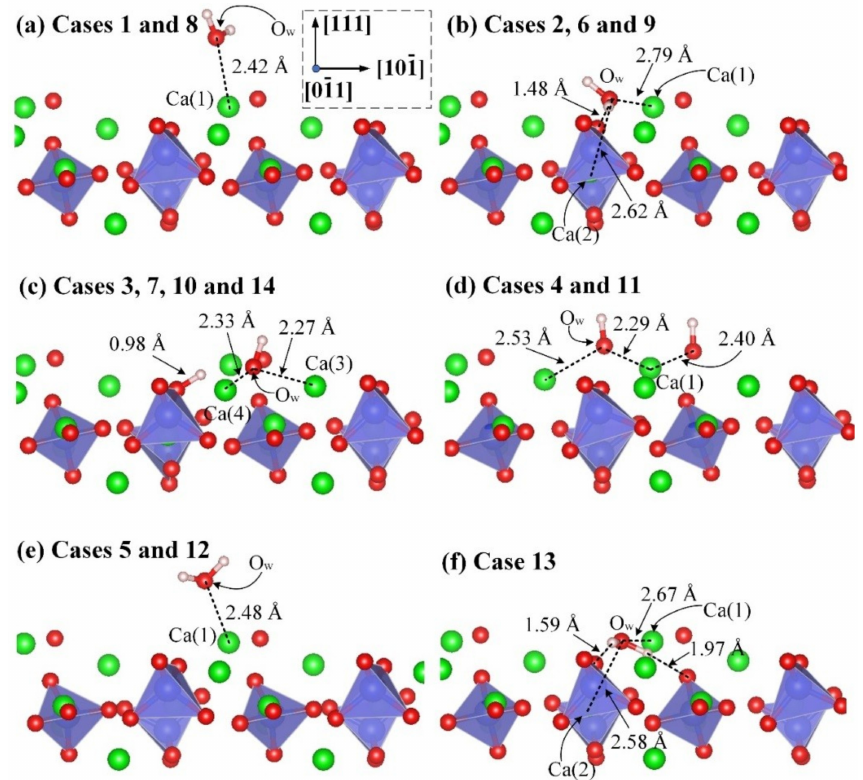
Figure A3. Side views of six adsorption configurations of a water molecule on the M3-C 3 S (111) surface.